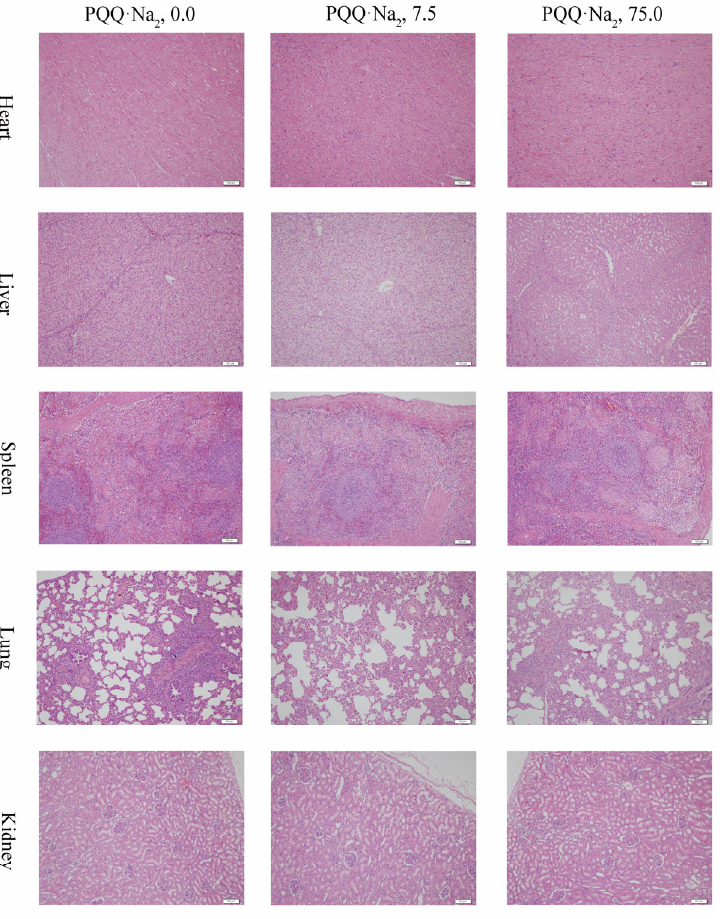
Figure 1. Effects of graded levels of PQQ · Na 2 on heart, liver, spleen, lung and kidney morphology in weaned piglets. Hematoxylin-eosin staining, scale bars = 100 µ m. When weaned pigs fed diets supplemented with 0.0 (control), 7.5 (low-dose) or 75.0 (high-dose) mg/kg PQQ · Na 2 , normal histological structures in the heart, liver, spleen and kidney were observed. The lungs of all experimental animals showed interstitial pneumonia characterized by massive infiltration of lymphoid